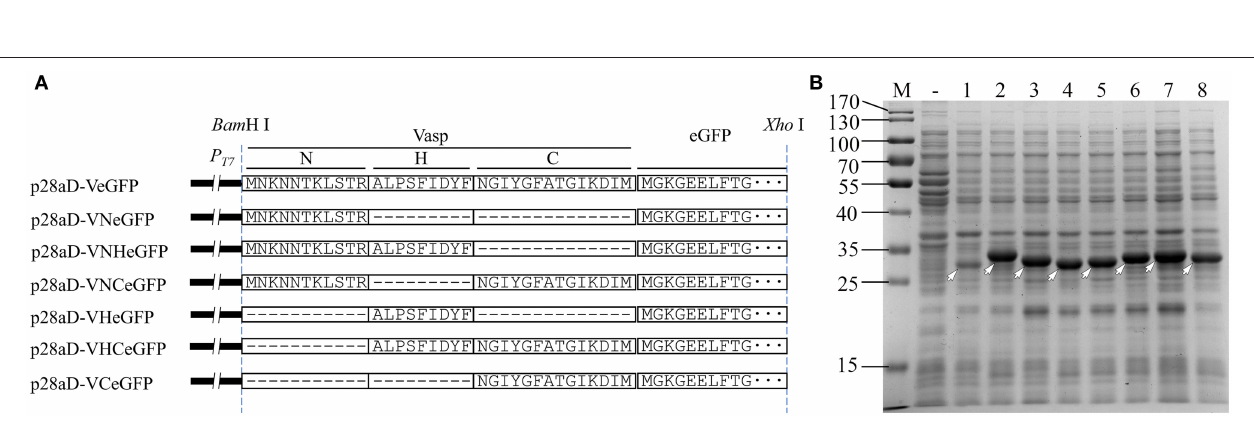
FIGURE 6 | Diagram of Vasp variants (A) and their effect (B) on the expression of eGFP. In panel B , the target bands of eGFP (lane 1), VeGFP (lane 2), VNeGFP (lane 3, 29.2 kDa), VHeGFP (lane 4, 29.1 kDa), VCeGFP (lane 5, 29.5 kDa), VNHeGFP (lane 6, 30.3 kDa), VNCeGFP (lane 7, 30.7 kDa), and VHCeGFP (lane 8, 30.6 kDa) are indicated by hollowed arrows, respectively. Lane “–” is the negative control prepared from BL28aD cells. Lane “M” is the molecular weight standard.